Question: Give a one-sentence summary of this figure.
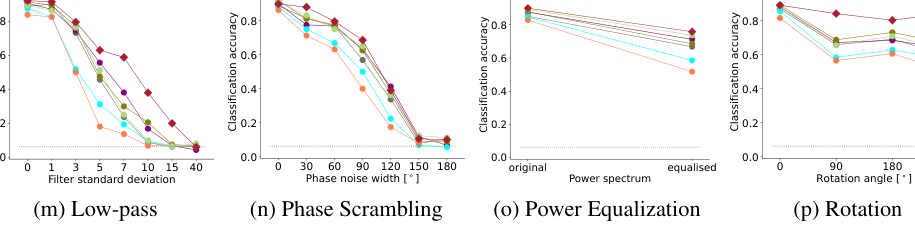
Answer: Detailed performance on 16 OOD datasets.